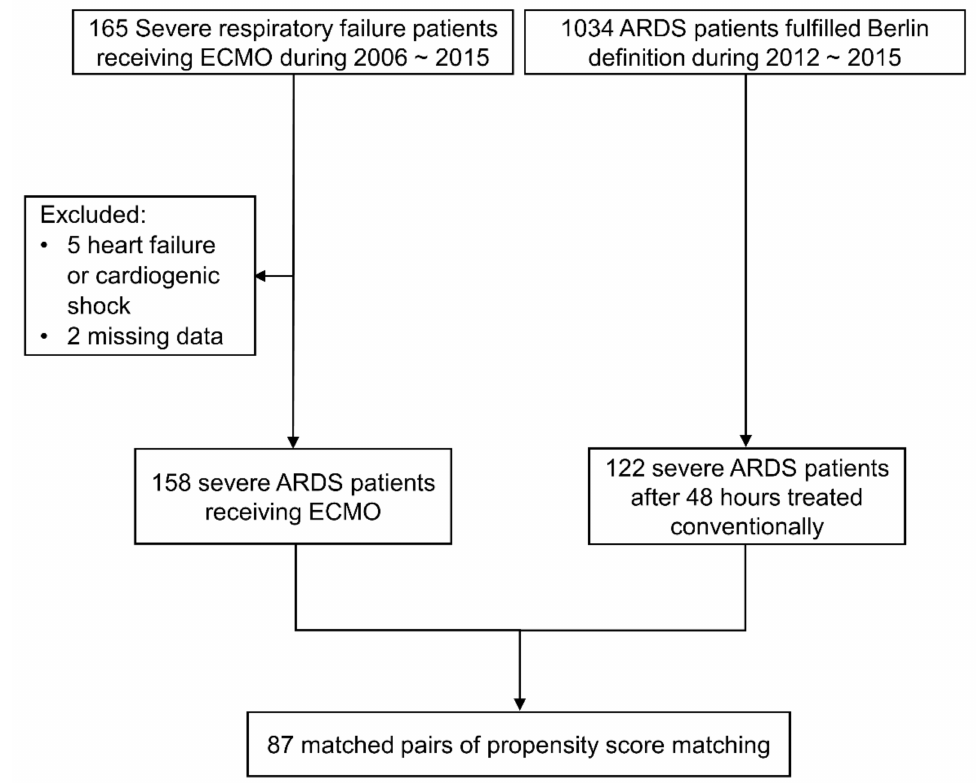
Figure 1. Flow diagram showing the enrollment of patients with severe ARDS who were or were not administered ECMO support via propensity score matching. (ARDS, acute respiratory distress syndrome; ECMO, extracorporeal membrane